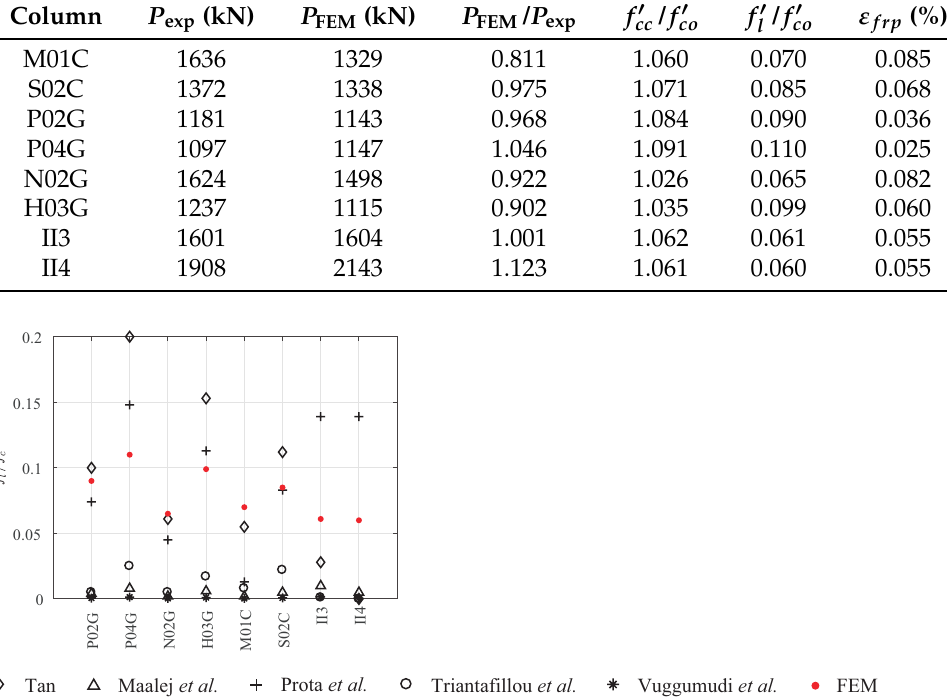
Figure 9. Lateral confining pressure ratio f (cid:48)